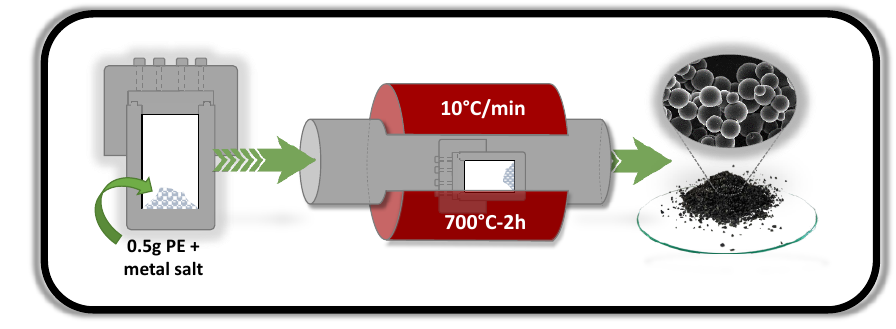
Figure 1. Experimental scheme of the synthesis process.